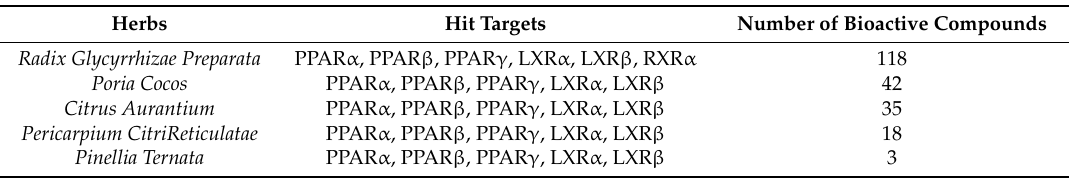
Table 3. Docking results of